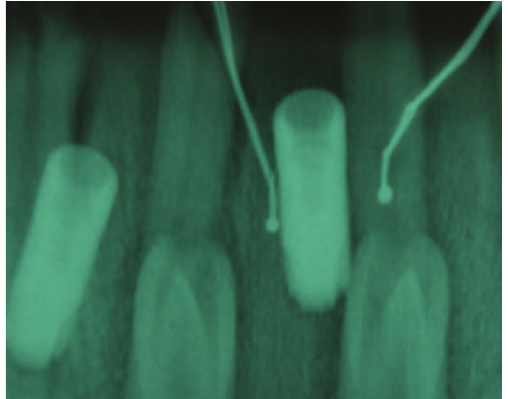
Figure 3: Rx check of the two thermocouples’ position.